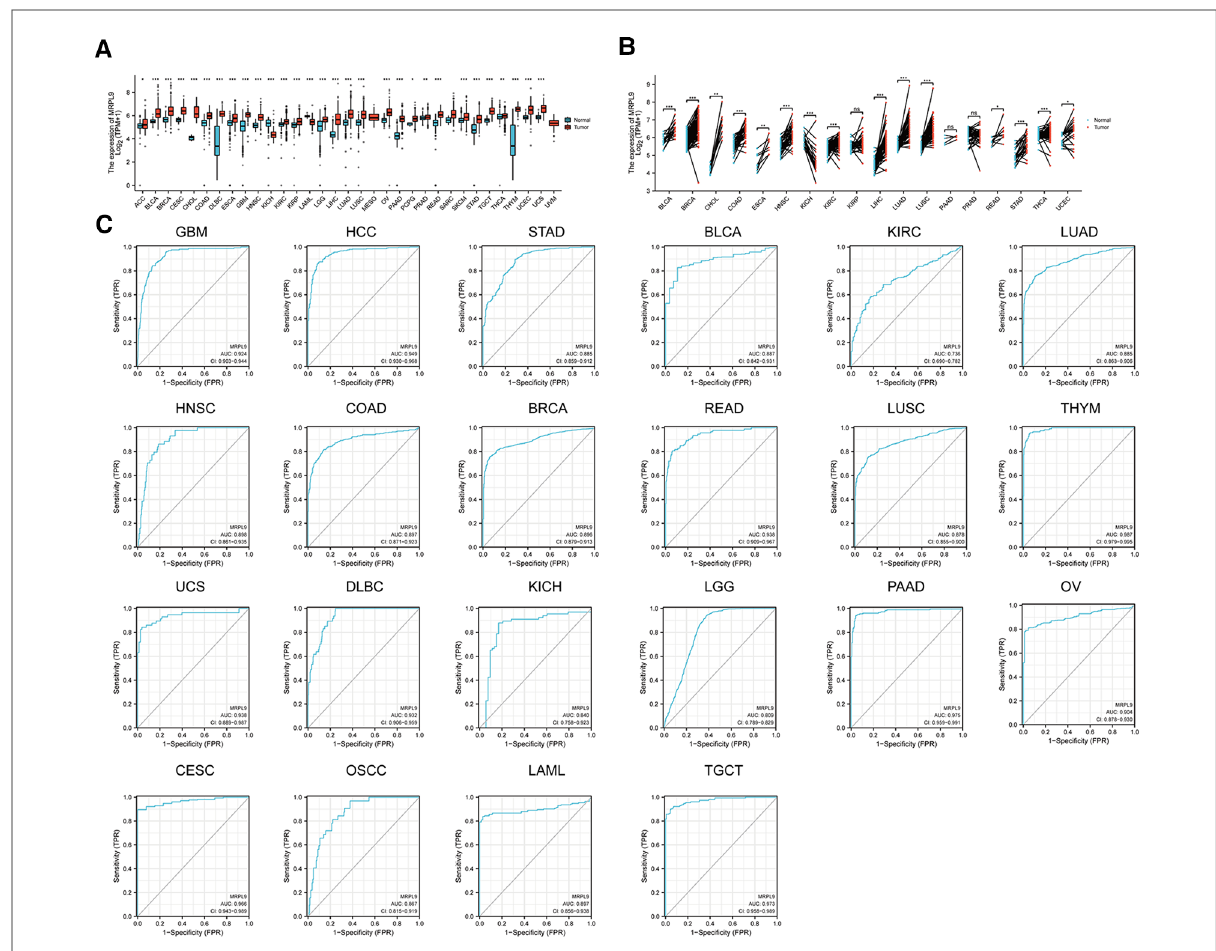
FIGURE 7 Expression and diagnostic roles of MRPL9 in the majority of tumors. ( A ) Transcriptional levels of MRPL9 in pan-cancer based on TCGA and GTEx datasets. ( B ) Expression of MRPL9 in tumor tissues and paired normal tissues based on TCGA fi les. ( C ) ROC plots illustrated the potential of MRPL9 in oncology